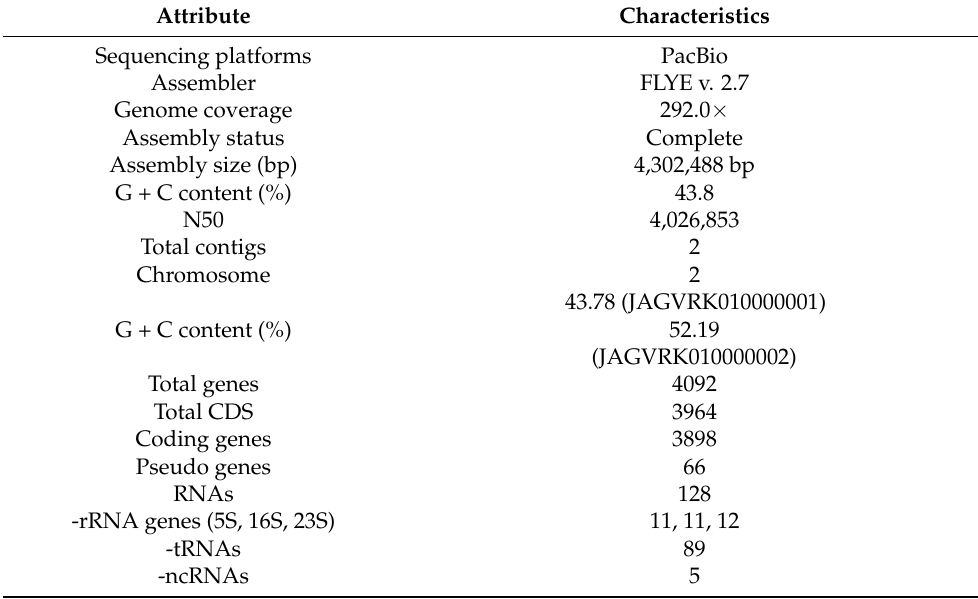
Table 3. General characteristics of the genome of strain KIGAM252 T . Attribute